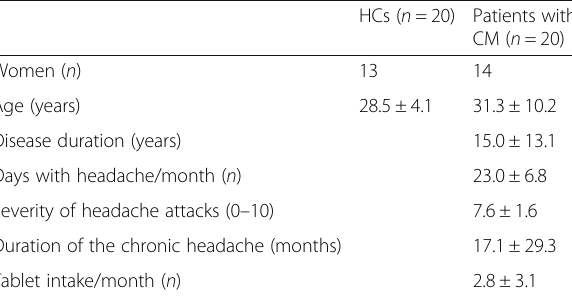
Table 1 Demographic data from patients with chronic migraine (CM) and healthy controls (HCs) and the headache profile of the